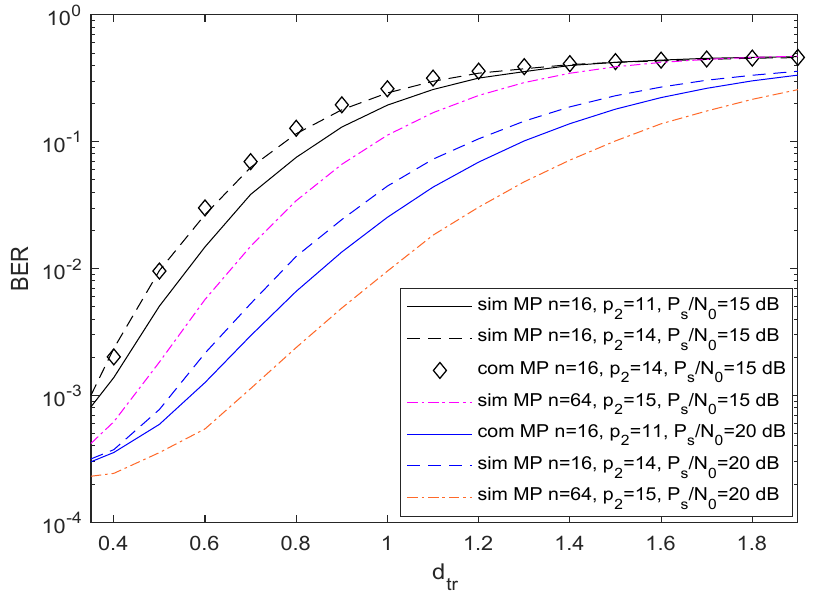
Figure 5. BER performance of GCI-DCSK SWIPT changes along with d tr over a multipath Rayleigh fading channel, where P s / N 0 = 15 dB and P s / N 0 = 20